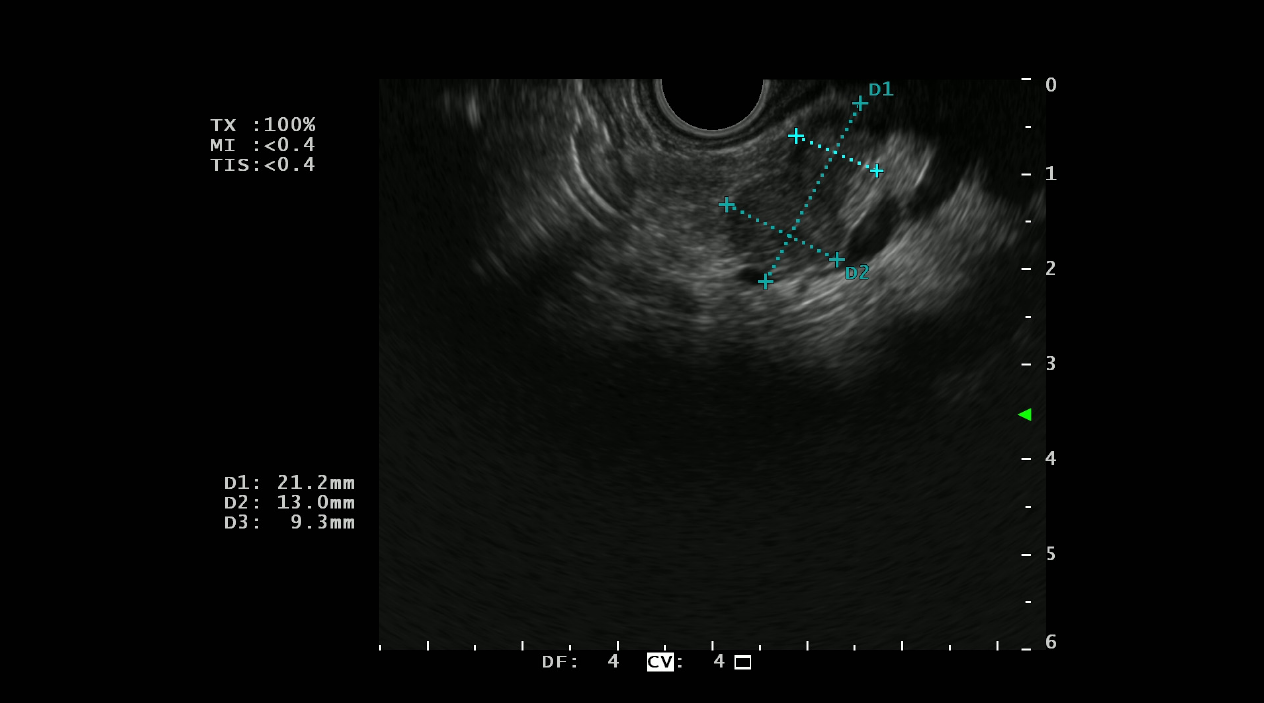
Figure 1. A hypoechoic lesion of 21 mm with regular margins (identified by the blu +) and an ipoechoic appearance; at histopathological analysis the lesion was a G1 NET. an ipoechoic appearance; at histopathological analysis the lesion was a G1